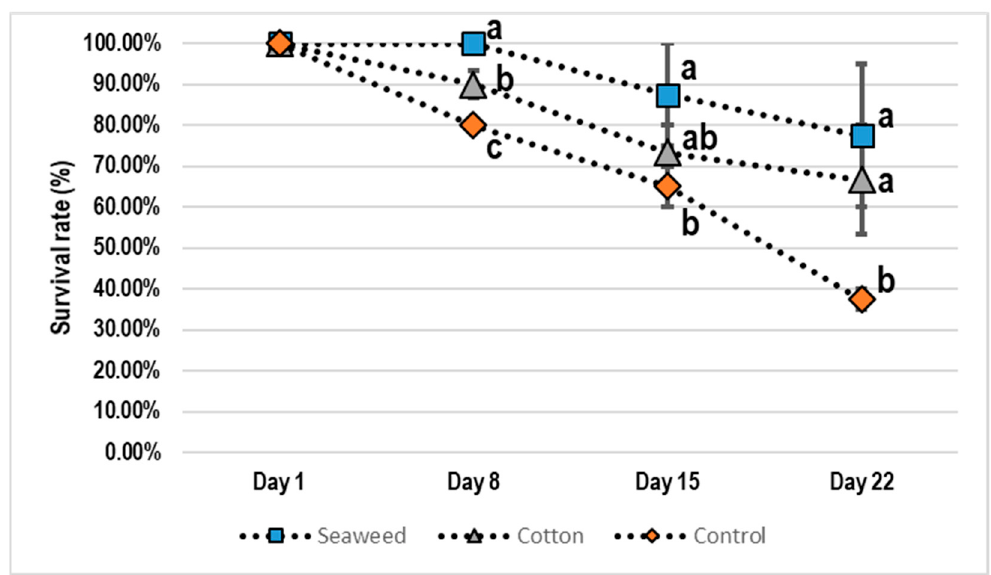
Figure 3. Charybdis feriatus shelter experiment. There was a significant difference at the beginning of the shelter experiment on Day 8, and then the survival rate of control gradually reduced. ■ seaweed; ▲ cotton filter; ◆ control ( a,b,c p < 0.05).